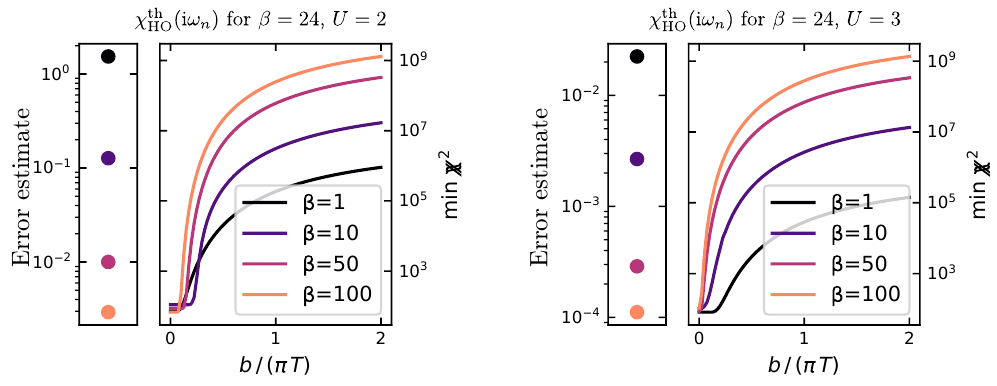
Figure 10: Harmonic oscillator test case. Error estimate and fit loss vs. blur width. Left: HO parameters corresponding to β = 24, U = 2 Right: HO parameters corre- sponding to β = 24, U =